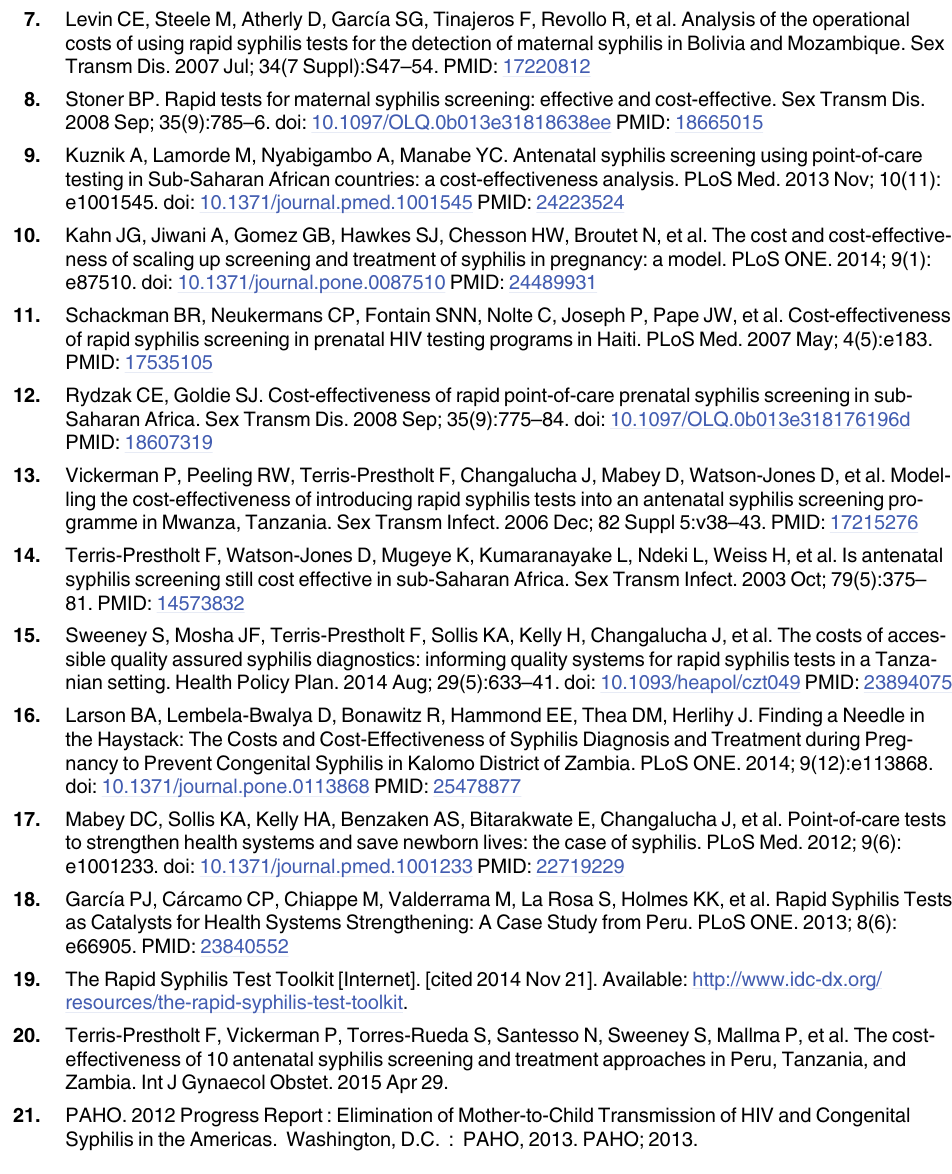
PLOS ONE | DOI:10.1371/journal.pone.0149568 March 7,